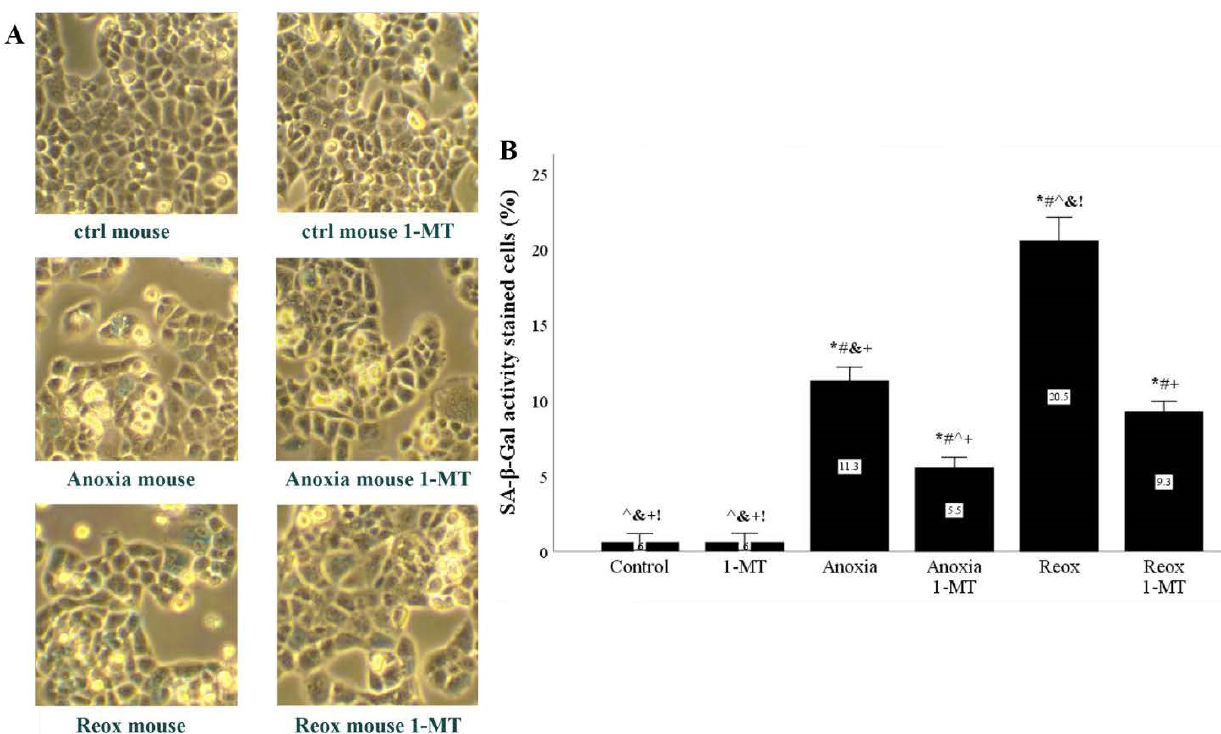
Figure 9. In mouse RPTECS, IDO inhibition decreased anoxia- or reoxygenation-induced upregulation of SA- β -Gal activity. Mouse RPTECs were cultured under anoxic conditions for 24 h or subsequently subjected to reoxygenation for another 2 h. A representative of three independent experiments is depicted in panel ( A ). Anoxia upregulated SA- β -Gal activity, which was further upregulated by reoxygenation. In both cases, the IDO inhibitor 1-MT decreased SA- β -Gal activity ( B ). * p < 0.05 vs. Control, # p < 0.05 vs. Control with 1-MT, ^ p < 0.05 vs. Anoxia, & p < 0.05 vs. Anoxia with 1-MT, + p < 0.05 vs. Reox, ! p < 0.05 vs. Reox with 1-MT. Error bars correspond to SEM. 1-MT, 1-DL-methyltryptophan; Reox, reoxygenation; SA- β -Gal, senescence- associated β -galactosidase.